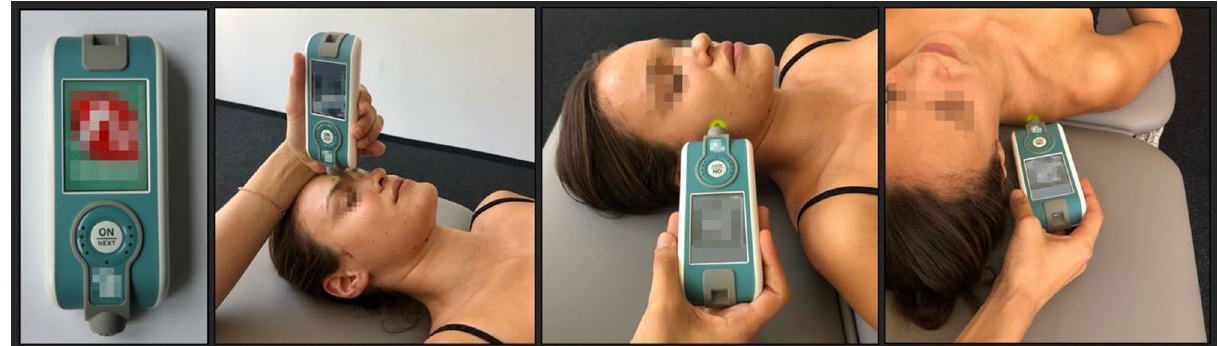
Figure 2. MyotonPRO; Legend: MyotonPRO and application for the CS, SM, and UT (from left to right).